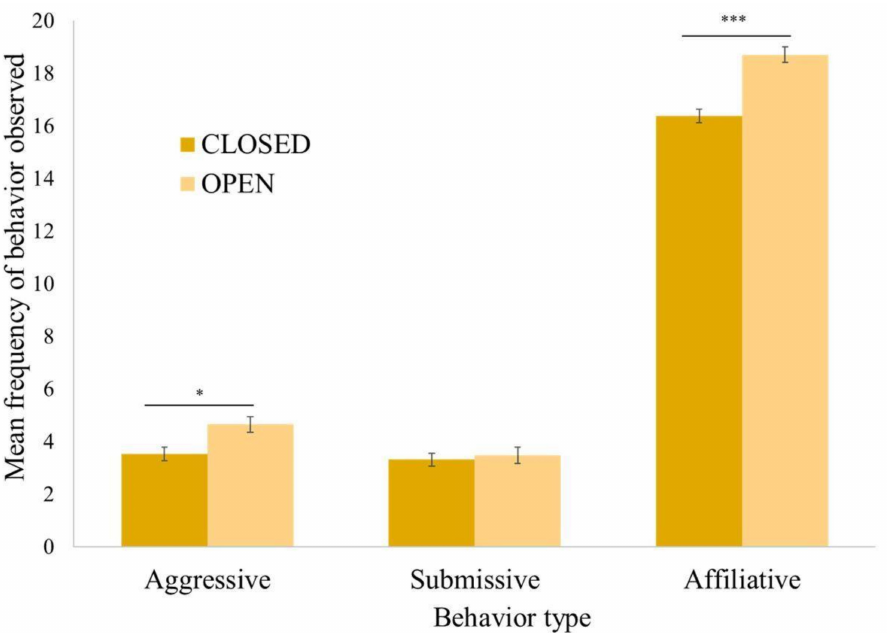
Figure 6. Mean frequency of aggressive, submissive, and affiliative behavior types observed overall during social integration by closed vs. open top locations. The critical level of the statistical signifi- cance was set at p ≤ 0.016 after a Bonferroni correction: * p ≤ 0.016, *** p ≤ 0.0005. Aggressive and affiliative behaviors were more frequently observed during social integration in open top locations than in closed locations. This was particularly the case for affiliative behavior.